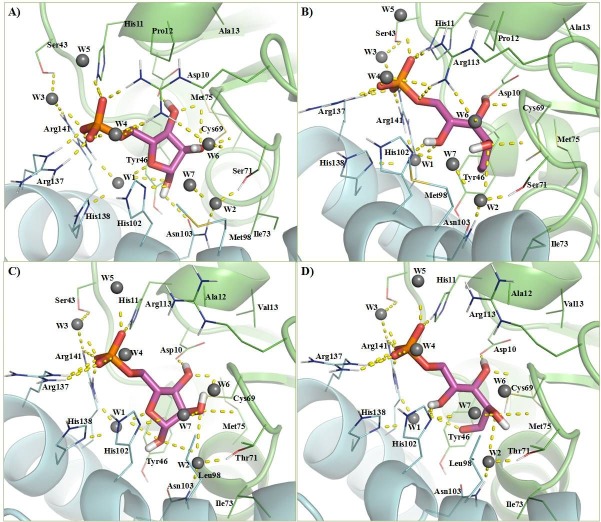
3D molecular recognition interaction diagram for F-form and C-form of substrate in TcRpiB (A) and (B) and LdRpiB (C) and (D).